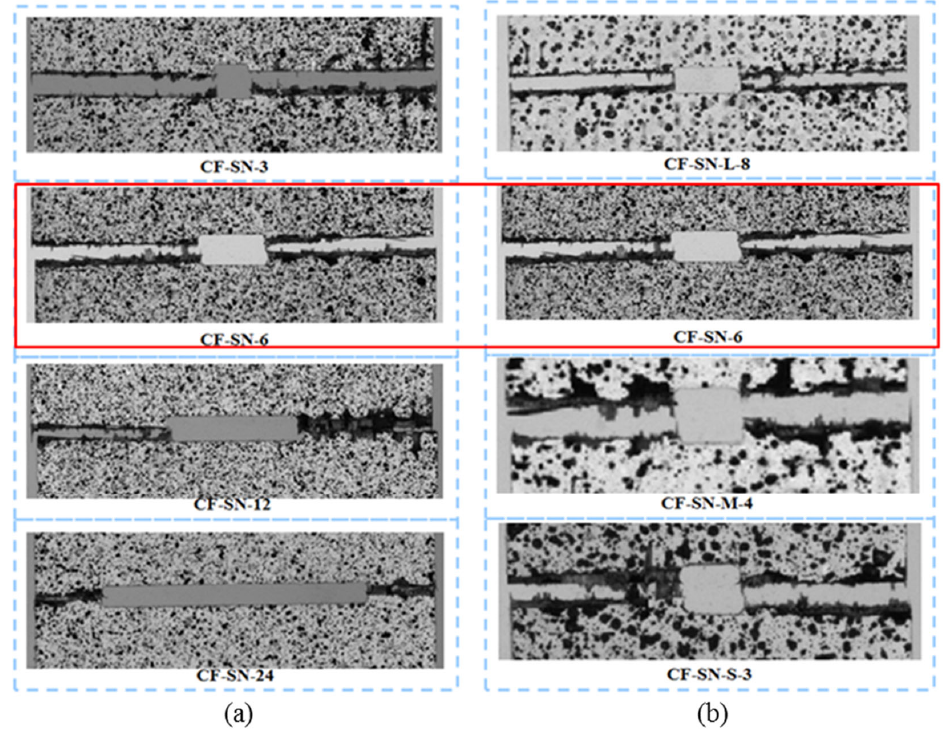
Figure 16. Local failure characteristic diagram of tensile specimens ( a ) with equal specimen size and ( b ) with an equal ratio of 𝑊 /2 𝐶 . No significant difference in the failure modes for specimens of this two groups; failure modes present mostly in fiber fracture and a small part of fiber pull-out and